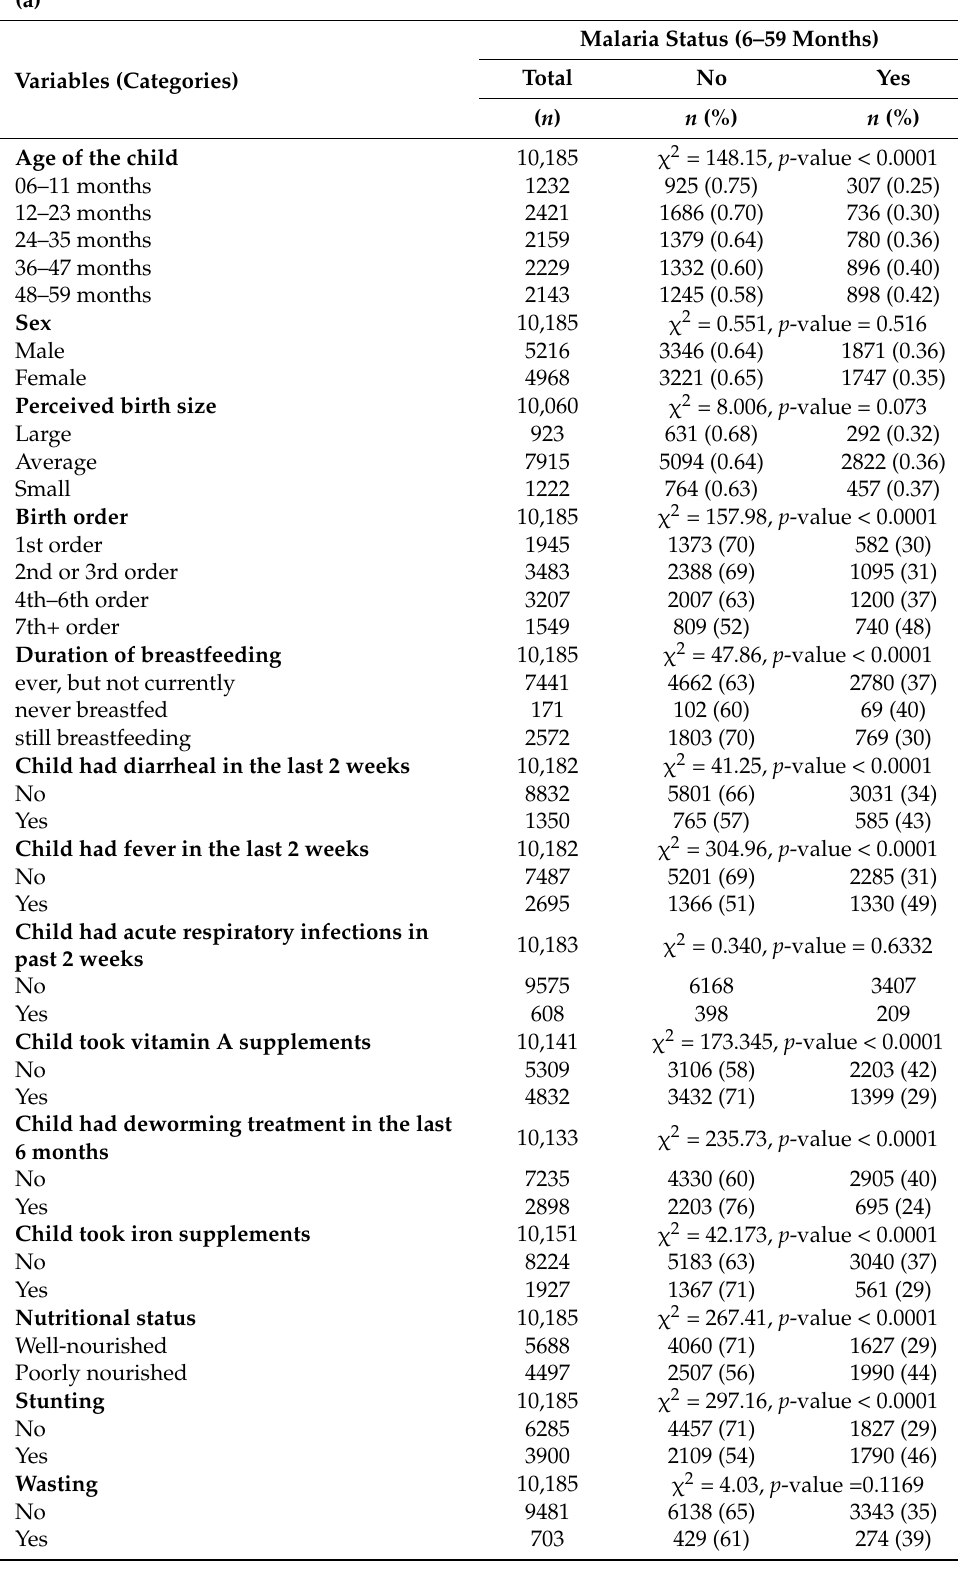
Table 1. ( a ) Crosstabulation of malaria status versus child-related predictors. ( b ) Crosstabulation of malaria status versus parental-related predictors. ( c ) Crosstabulation of malaria status versus household-related predictors. ( d ) Crosstabulation of malaria status versus community-related predic- tors. ( e ) Crosstabulation of malaria status versus area-related